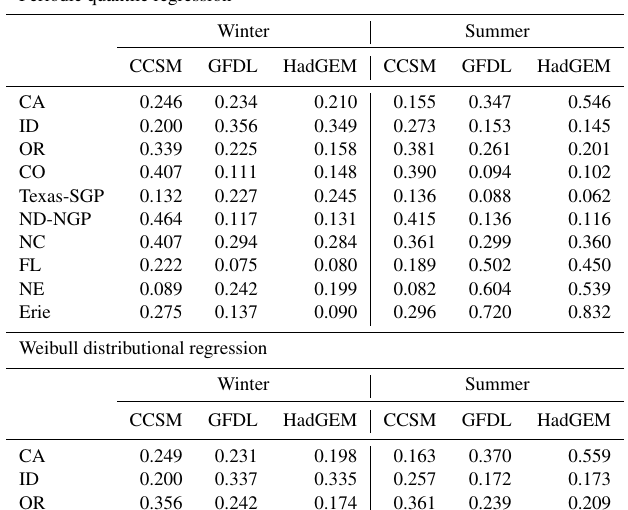
Table B1. Summary metrics with WIRE for all stations in winter and summer seasons during 1995–2008 at 95% quantile level via quantile regression, Weibull directional models for wind speed, and von Mises distribution for wind direction. Periodic quantile